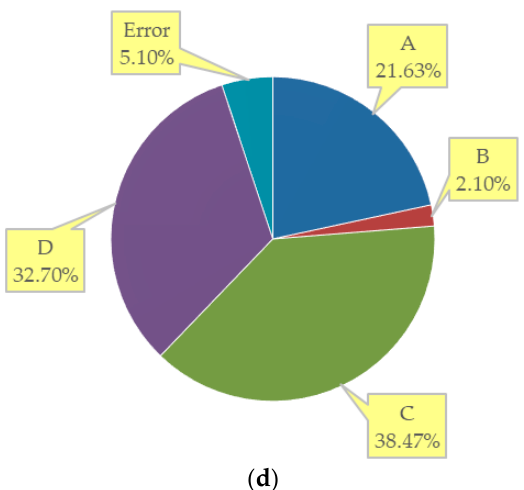
Figure 17. Distribution of contribution ratio for: ( a ) Flexural strength; ( b ) IF index; ( c ) PF index; ( d ) UF index.